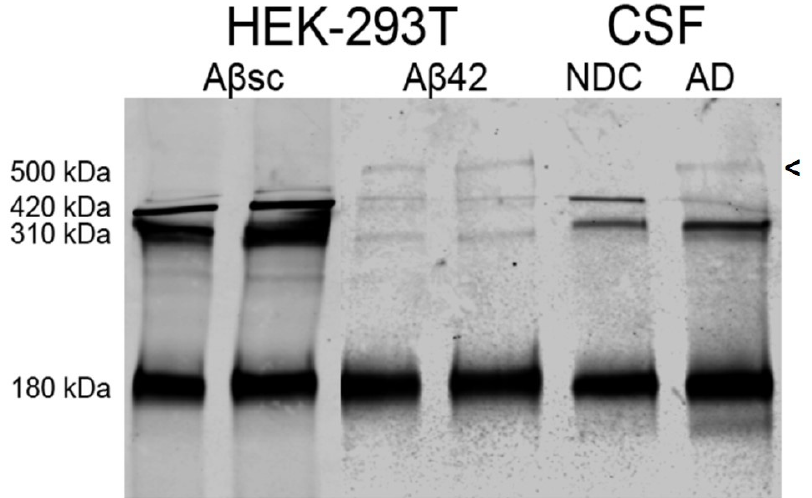
Figure 3. The 500 kDa reelin species was present in cell medium of HEK-293T treated with A β 42. A representative blot showing the reelin immunoreactive bands detected with an N-terminal antibody from HEK-293T cells overexpressing reelin treated with A β 42 or an A β sc peptide. CSF samples from NDC and AD subjects were included to monitor the potential occurrence of the ~500 kDa species. When the cells were treated with A β 42 peptide, a reelin immunoreactive band resembling the ~500 kDa band present in AD CSF was detected; this band was not present when the cells were treated with the A β sc peptide. Arrowhead indicates the ~500 kDa band.